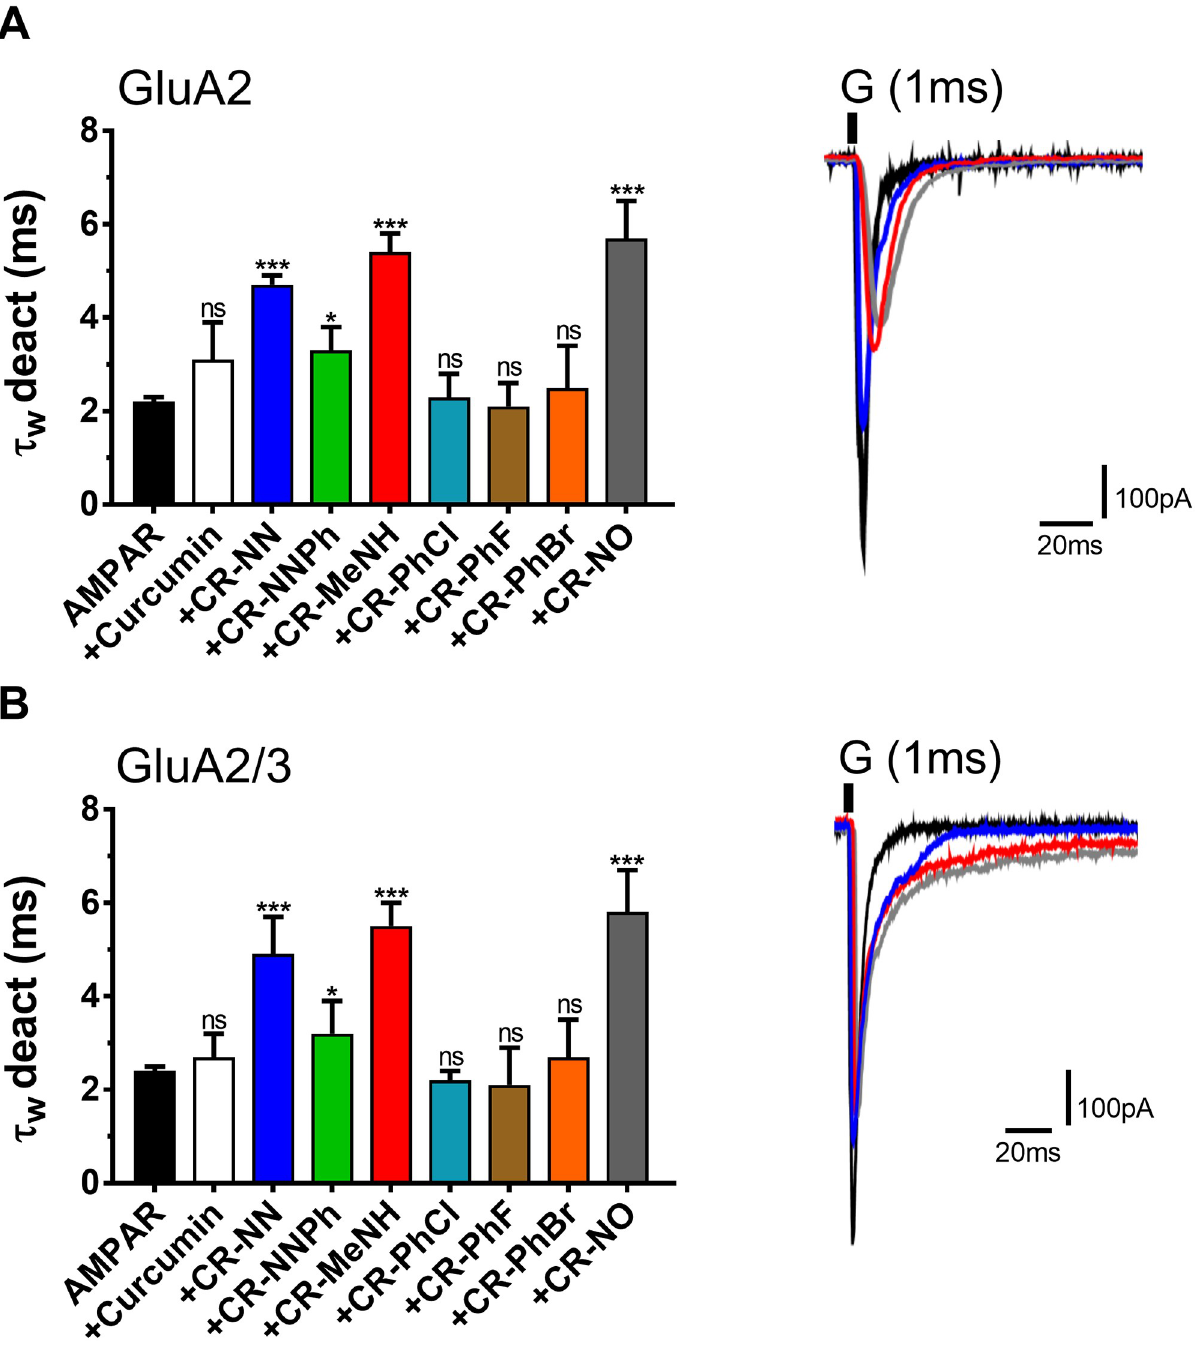
Fig 4. Effect of Curcumin and the derivatives on AMPAR deactivation. A is the deactivation time in milliseconds (ms) from HEK293 cells expressing homomeric GluA2 alone or in combination with derivatives. B is the deactivation time in milliseconds (ms) from HEK293 cells expressing heteromeric GluA2/3 alone or in combination with derivatives. The whole-cell current recording was conducted at − 60 mV, pH 7.4, and 22 ˚C. Graphs summarize weighted time constants for desensitization ( τ W des). Data shown are mean ± SEM; n = 6 (number of patch cells in the whole-cell configuration). Significance (one-way ANOVA): � p < 0.05; �� p < 0.01; ��� p < 0.001; ns, not significant.